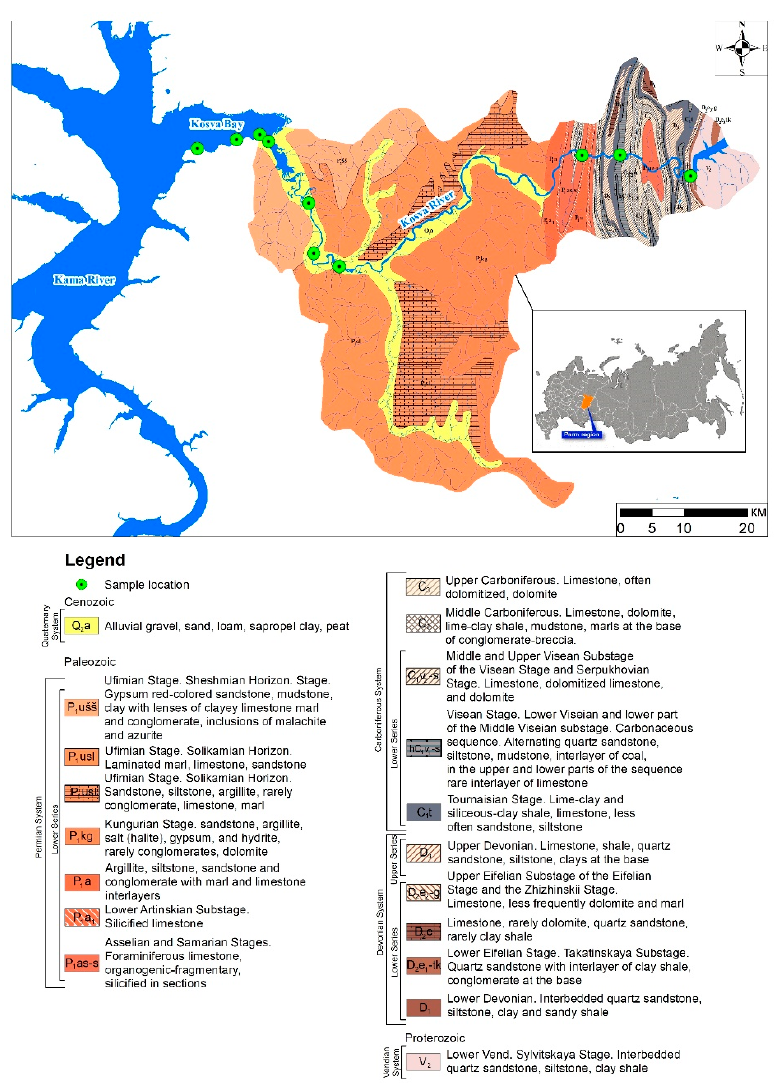
Figure 2. Geological map of the study area with the location of the sampling points.